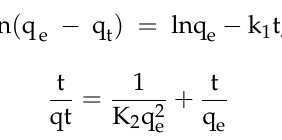
Table 1. Adsorption kinetic parameters for MB adsorption of CNC-g-AA-2-120-8 aerogels.